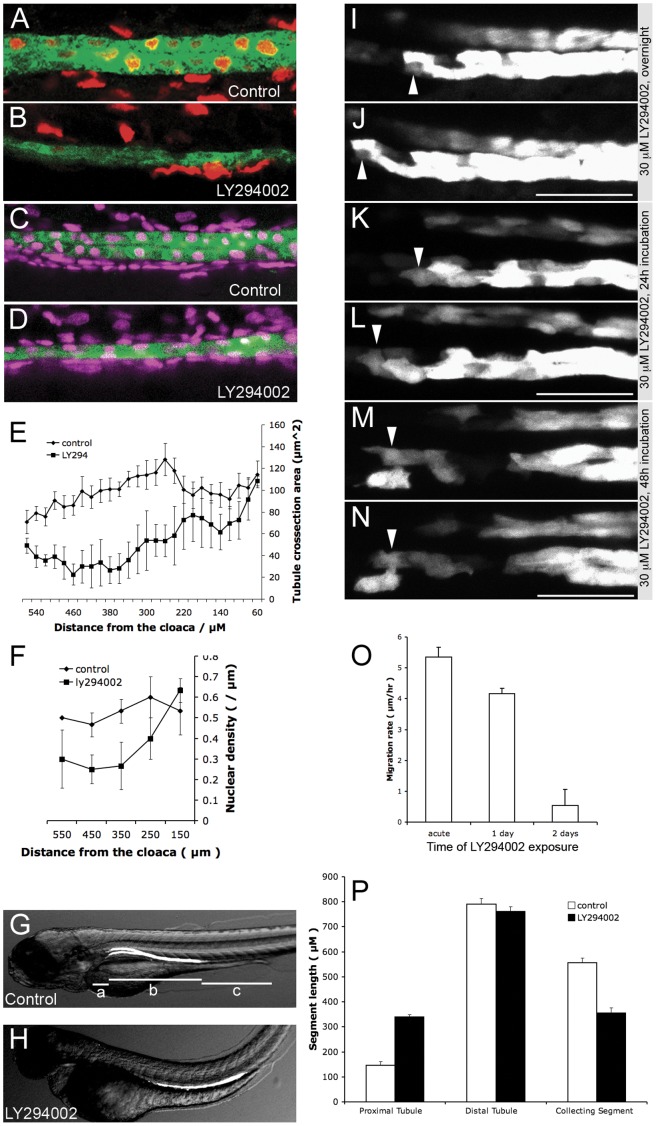
Distal proliferation supports prolonged epithelial migration.(A–D) 1.5 µm confocal slices of the distal tubule. Green: GFP (ET11-9 GFP transgenic in A–B, Tg(atp1a1a.4:GFP) transgenic in C&D). Red: BrdU. Magenta: DAPI. (A) BrdU incorporation in the distal tubule (2–3 dpf) in control fish. (B) Lack of BrdU incorporation in distal tubule between (2–3 dpf) when embryo is treated with 30 µM LY294002. Cells outside of the kidney continued to incorporate BrdU. (C) DAPI staining of distal tubule in control fish (4 dpf). (D) DAPI staining of distal tubule treated with 30 µM LY294002 (4 dpf). The distal tubule was markedly thinned in LY294002 condition (B, D). (E) estimated cross-sectional tubule area based on measured maximal diameter of the tubule in confocal stacks at 3 dpf. Circles: control (n = 5). Squares: LY294002 treated fish (n = 3). (F) Linear nuclear density (DAPI) in control fish (circles, n = 3) and LY294002 treated fish (squares, n = 3) confirmed linear stretching of the distal tubule in Ly294002 treated fish (4 dpf). (G, H) Kidney segment lengths in (G) control fish and (H) LY294002 treated fish at 4dpf. ET11-9 transgenic fish were used to estimate the segment lengths: ‘a’, ‘b’ and ‘c’ represent proximal tubule, distal tubule and the pronephric duct. (I–N) Individual frames of time lapse movies of the actively migrating pronephric epithelia in the presence of 30 µM LY294002. Arrowheads point to the individual traced cells. Time lapse immediately after addition of LY294002 (I, J), 24 hours after addition of LY294002 (K, L), and 48 hours after addition of LY294002 (M, N). Frame pairs in I and J, K and L, and M and N are separated by 6 hours. (O) Average epithelial migration rates after different durations of LY294002 exposure. Each bar represents average migration rate of 4 different individual cells in the proximal tubule (ET11-9:GFP). (P) Lengths of proximal tubule (designated ‘a’ in G), distal tubule (designated ‘b’ in G) and pronephric duct (designated ‘c’ in G) in control 96 hpf fish and fish treated with 30 µM LY294002 starting at 30 hpf. White bars: control (n = 9), black bars: LY294002 (n = 9). See also Figure S2.